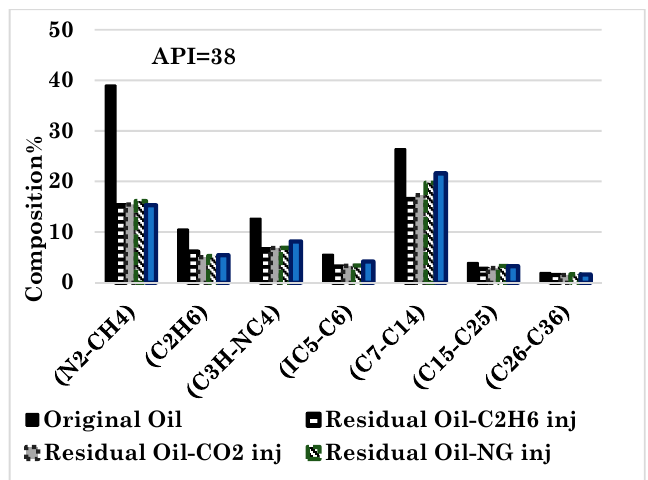
Figure 5. Composition of oil before and after natural depletion (ND) and CGI by CO 2 , C 2 H 6 and NG.